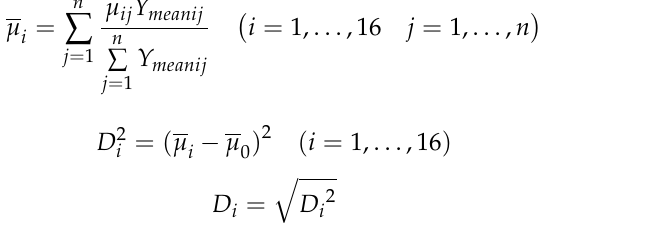
D and offset moment K of the weighted DLAs. ( a ) and offset moment K of the weighted i i